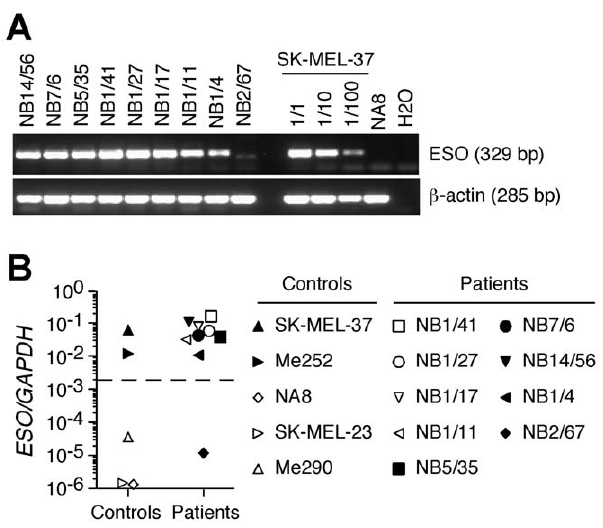
Figure 2. Assessment of ESO expression in BC tumors from ESO Ab + patients. ESO expression in cryopreserved BC tumors from ESO Ab + patients was assessed by semi-quantitative PCR ( A ) and qPCR ( B ) using specific primers and ESO + (SK-MEL-37, Me252) and ESO 2 (NA8, SK-MEL-23, Me290) tumor cell lines as internal controls.